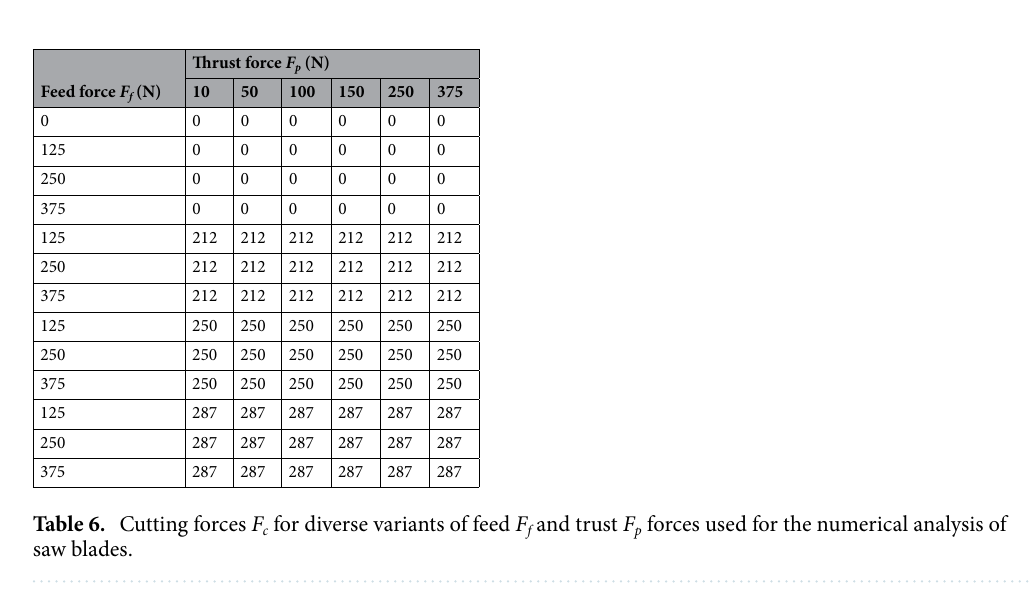
Figure 6. Boundary conditions for the simulated saw blades: top support for the narrow-kerf (a) and scraper saw blade (b) , the bottom support for the narrow-kerf (c) and scraper saw blade (d) (drawing designed in Dlubal https:// www. dlubal. com).